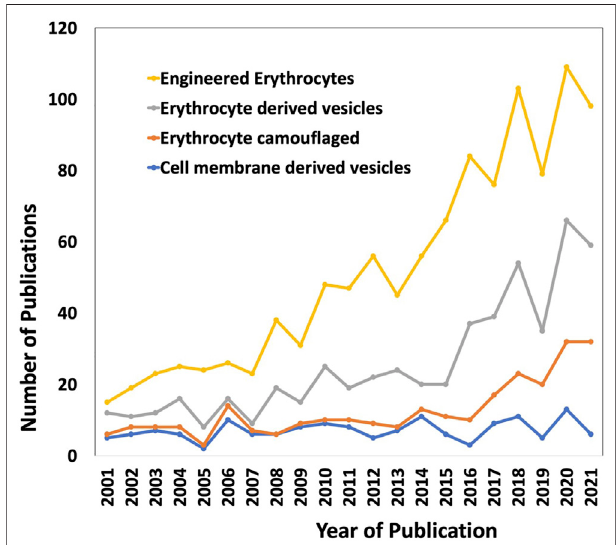
FIGURE 1 | The research trend of using RBCs as delivery vehicles in the past two decades (2001 – 2021). The keywords used are “ Engineered erythrocytes ” , “ Erythrocyte derived vesicles ” , “ Erythrocyte camou fl aged ” and “ Cell membrane-derived vesicles ” . The data were obtained from Web of Science.